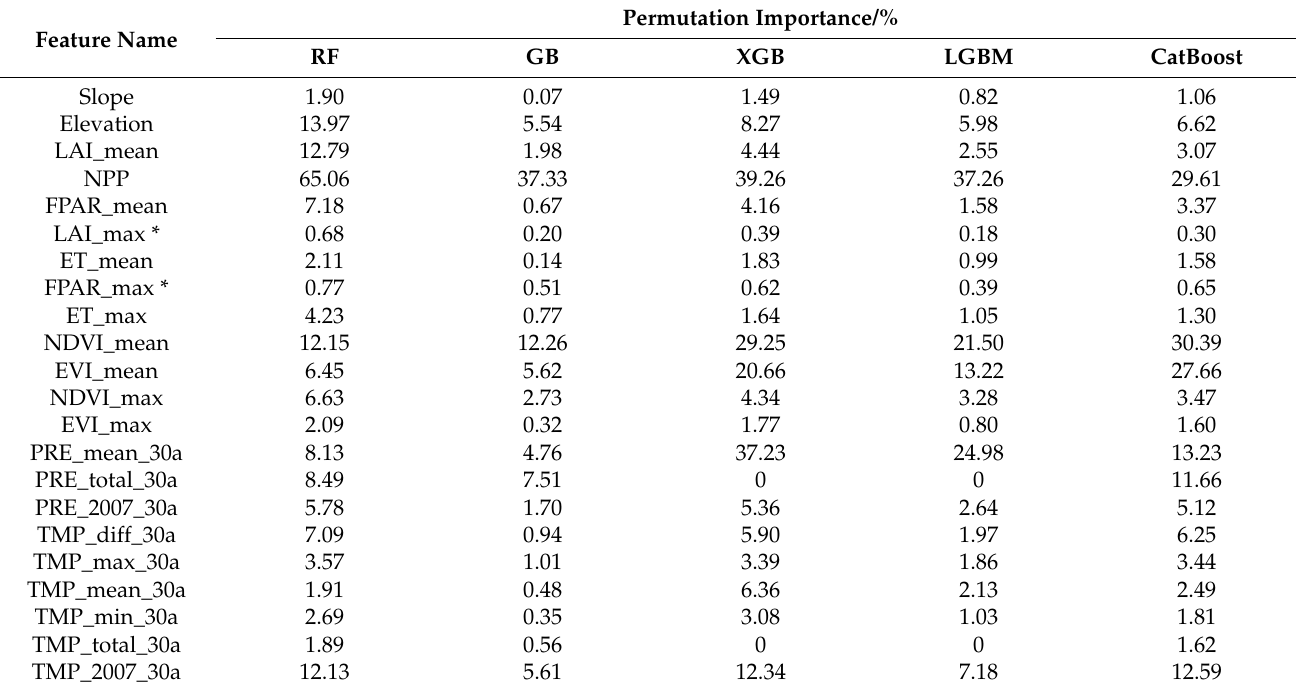
Table 4. Permutation importance of the 22 features in the pre-test. * denotes that the feature was eliminated due to its importance was less than 1% in all the reserved models.